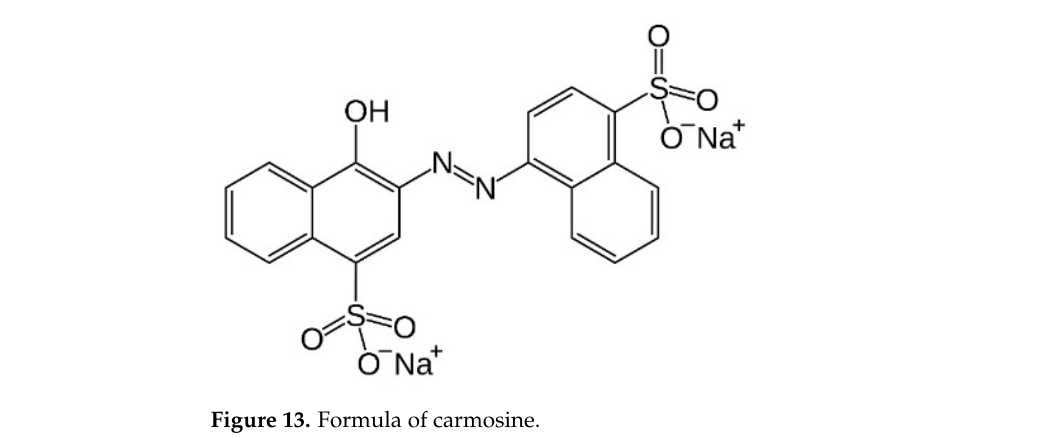
Figure 13. Formula of carmosine.